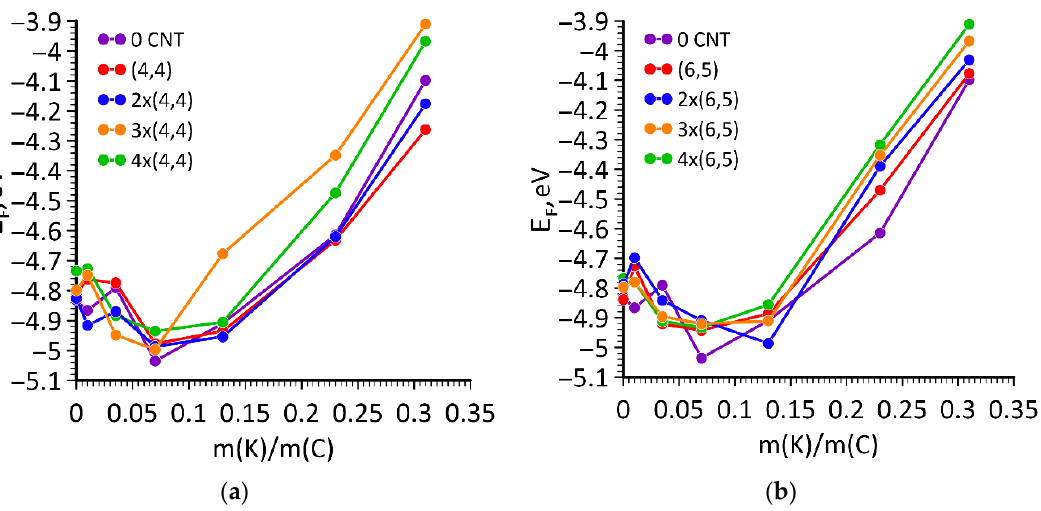
Figure 3. Dependence of the Fermi energy E F on the potassium/carbon mass ratio (m(K)/m(C)) for GLC reinforced (4,4) ( a ) and (6,5) ( b ) SWCNTs.